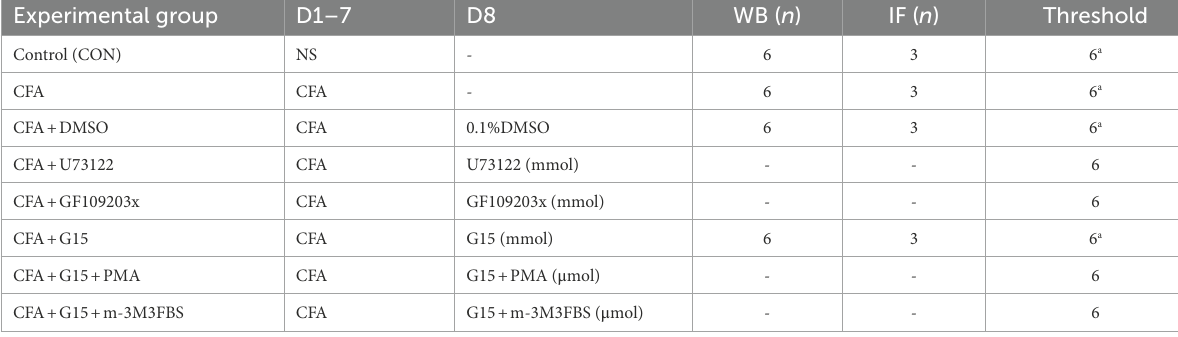
TABLE 1 Animal numbers in each group, administration time (day, D ), and sample size (number, n ) of rats per group. Experimental